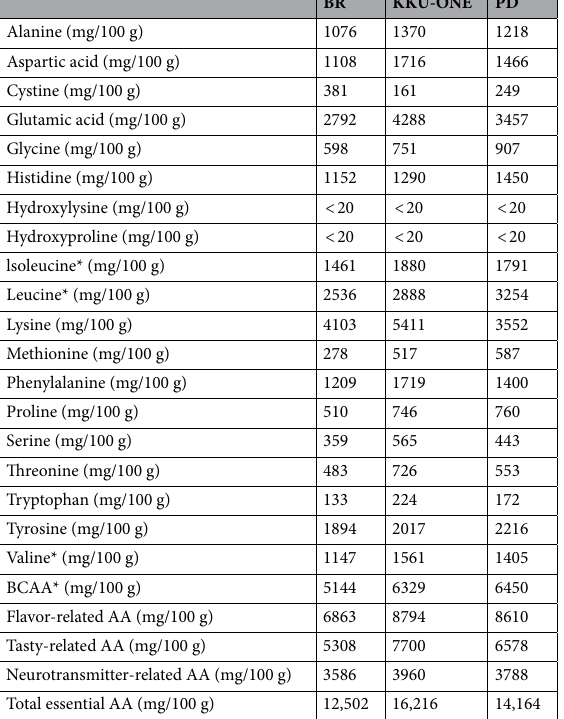
Table 1. The amino acid composition of breast meat from different chicken breeds. BR: Commercial broiler, KKU-ONE: commercial broiler × Thai native crossbred, PD: Thai native chicken (Pradu Hang Dam); BCAA: valine, leucine, isoleucine; Flavor-related AA: valine, leucine, isoleucine, phenylalanine, proline; Neurotransmitter-related AA: phenylalanine, tryptophan, tyrosine; Tasty-related AA: glutamic acid, alanine, glycine, serine, threonine; Total essential AA: histidine, isoleucine, leucine, lysine, methionine, threonine, tryptophan,